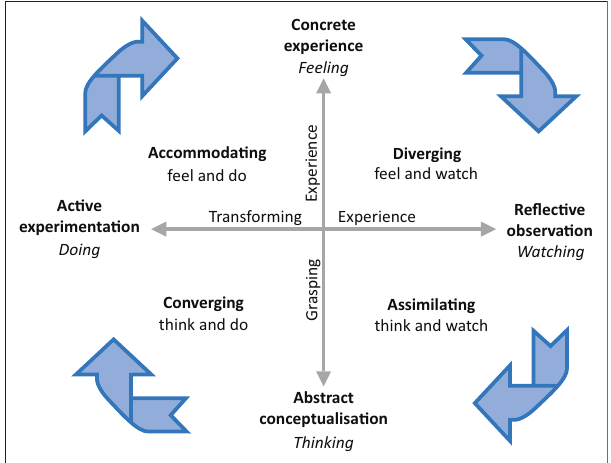
FIGURE 1: Kolb’s learning cycle and experiential learning